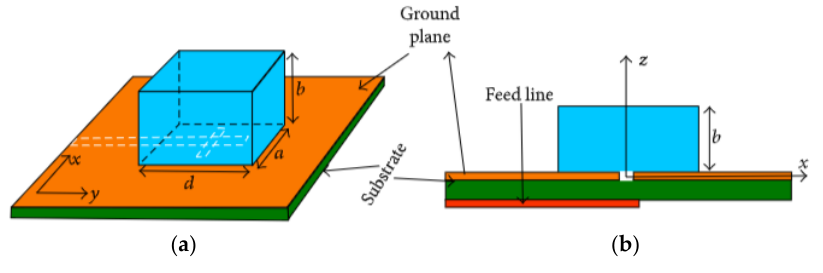
Figure 4. Rectangular DRA: ( a ) 3D view; ( b ) side view [33].